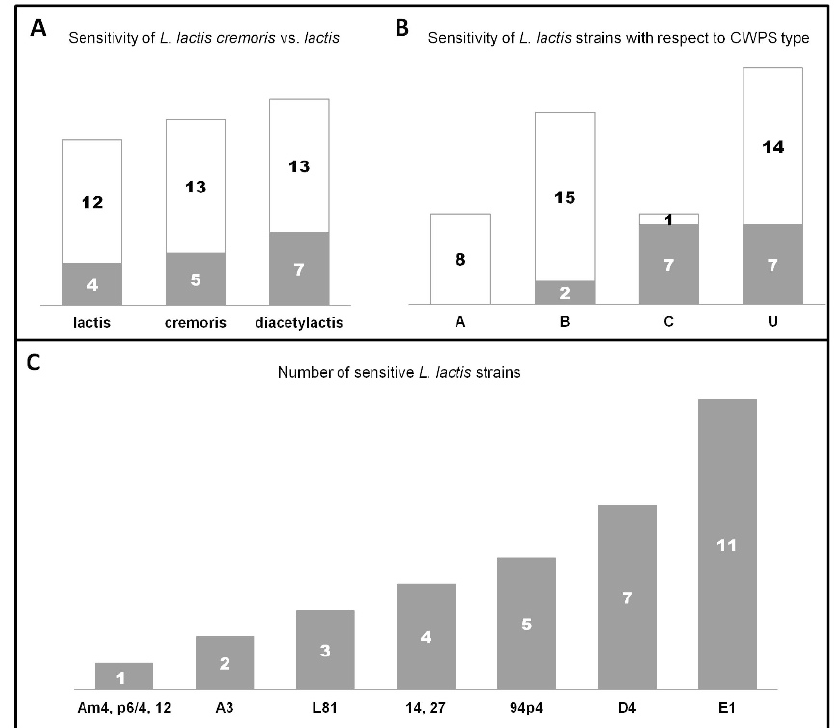
Figure 3. Infectivity of Ceduovirus phages towards a set of industrial and environmental L. lactis strains. Sensitive strains are marked in gray, resistant strains in white. ( A ) Sensitivity of L. lactis cremoris vs. lactis subspecies to infection by the analyzed phages. ( B ) Sensitivity of L. lactis strains with respect to their cell wall polysaccharide (CWPS) type. Clear lytic zones obtained on double-layer plates containing o / n cultures of a specific L. lactis strain (200 µ L) and phage lysates (100 µ L) were indicative of bacterial sensitivity. ( C ) Number of L. lactis strains (from 54 tested) sensitive to infection by individual phages.